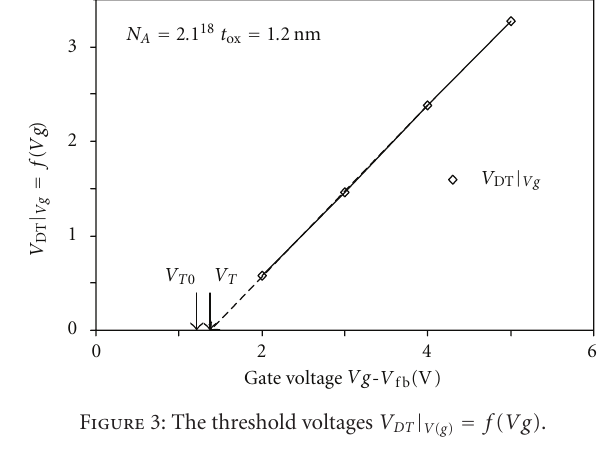
Figure 3: The threshold voltages V DT | V ( g ) = f ( Vg ).